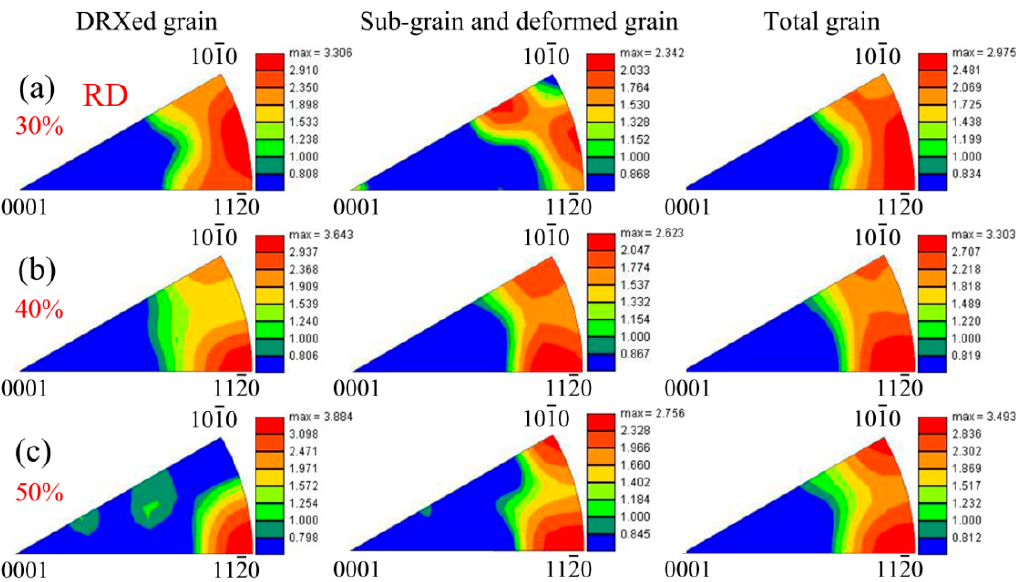
Figure 9. Inverse pole figures along the RD for dynamic recrystallized (DRXed) grain region, subgrain, and deformed grain region, and total grain region in ( a ) 400 ◦ C—30%, ( b ) 400 ◦ C—40%, and ( c ) 400 ◦ C—50%.